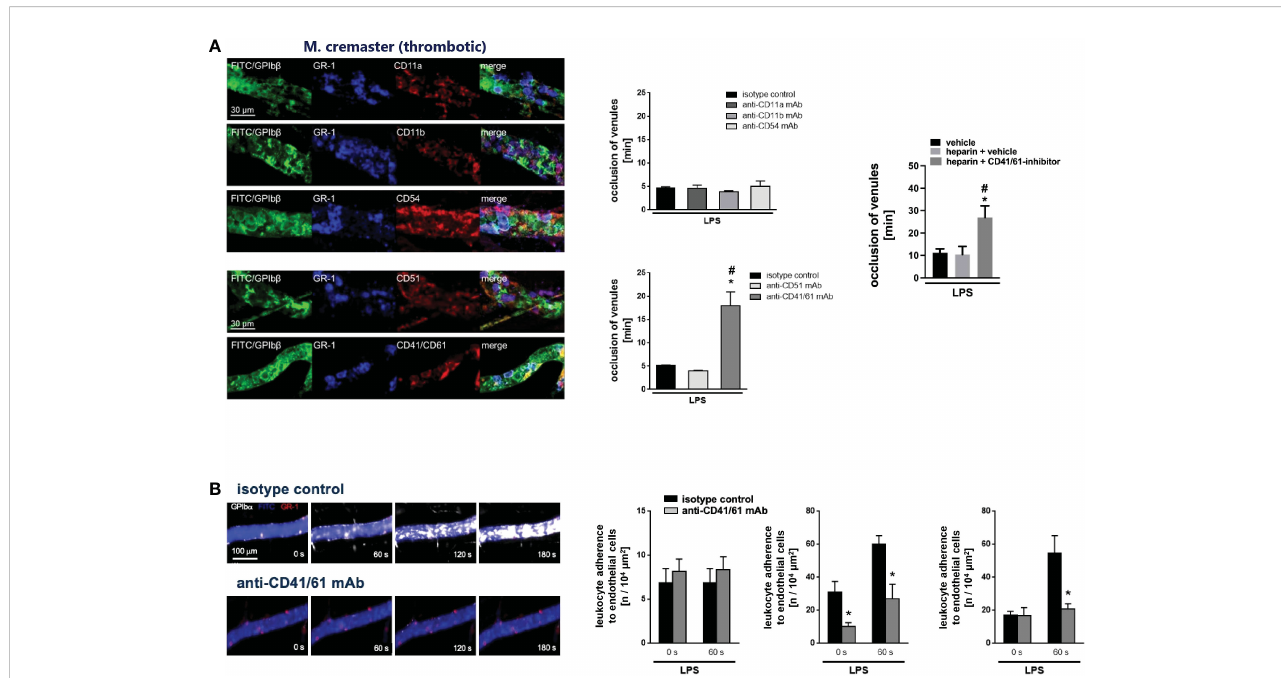
FIGURE 3 Microvascular immunothrombosis is controlled by the VN receptor CD41/CD61. (A) Presence of CD11a/LFA-1, CD11b/Mac-1, and CD54/ICAM-1, the VN interaction partners CD51 and CD41/CD61, as well as of GPIb b + platelets and GR-1 + myeloid leukocytes in venular immunothrombi as assessed by immunostaining and confocal microscopy in the LPS-stimulated cremaster muscle of WT mice, representative images are shown. Photochemical injury- elicited thrombus formation as assessed by multi-channel in vivo microscopy in LPS-stimulated cremasteric venules of WT mice receiving blocking monoclonal antibodies directed against CD11a, CD11b, CD54/ICAM-1, CD51, CD41/CD61, or heparin or heparin and a CD41/CD61 inhibitor, or isotype control antibodies/drug vehicle, representative data are shown (n=3-4 per group; #p<0.05 vs. isotype control). (B) Interactions of single GPIb b + platelets, GR-1 + myeloid leukocytes, and endothelial cells prior to induction of (0 s) or 60 s after induction of photochemical injury-elicited thrombosis in LPS- stimulated cremasteric venules of WT mice receiving isotype control or blocking monoclonal antibodies directed against CD41/CD61, representative images and quantitative data are shown (n=4 per group; *p<0.05 vs. isotype